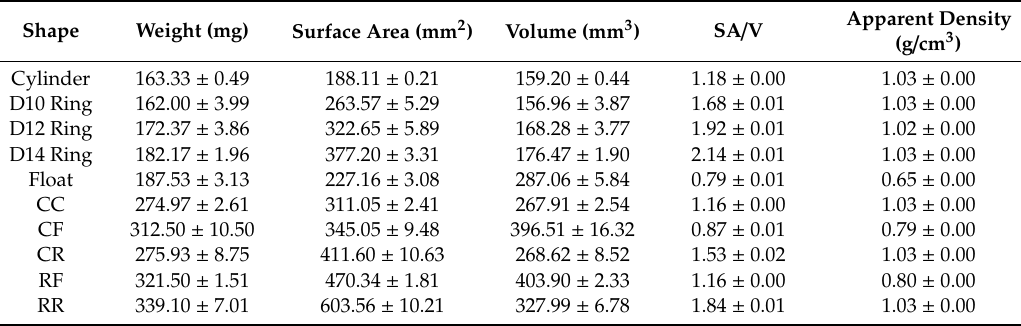
Table 1. Physical properties of printed solid dosage forms. ( n = 3, Mean ±